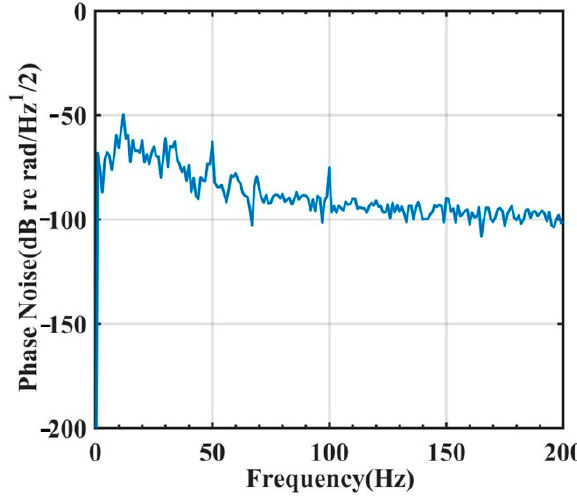
Figure 13. System background phase noise spectrum level.